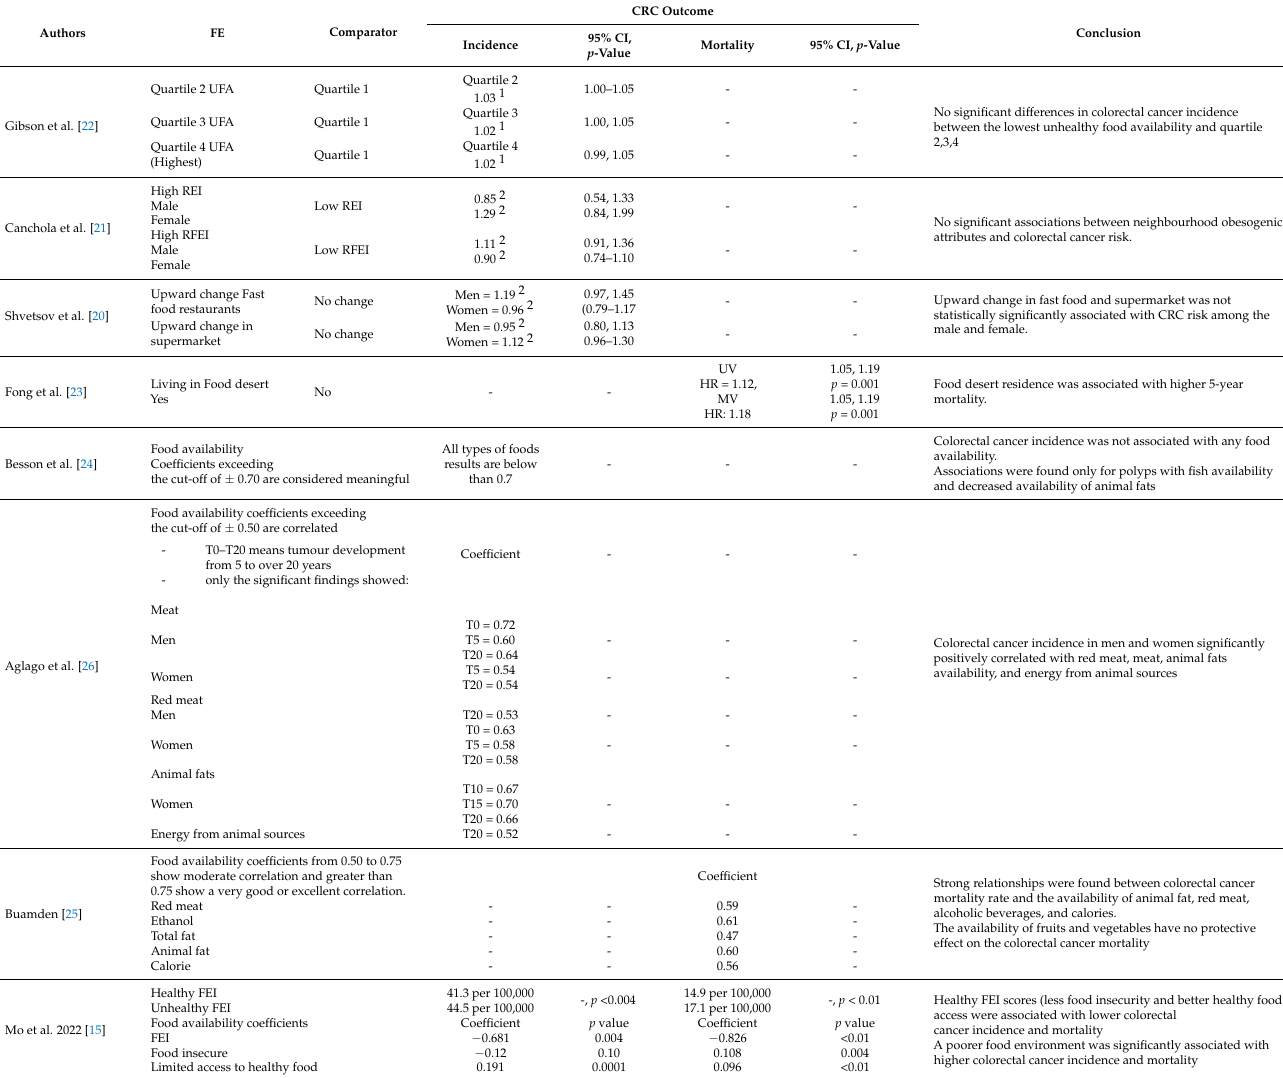
Table 6. The association between the food environment attributes and